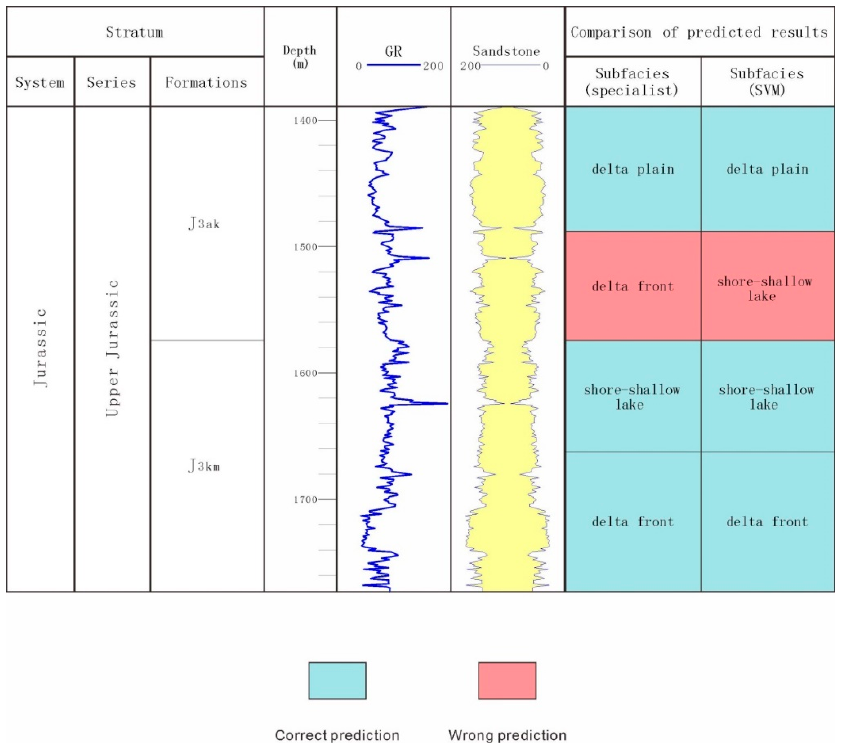
Figure 7. Comparison of the subfacies identification results by the SVM and geologists in well ARY14.